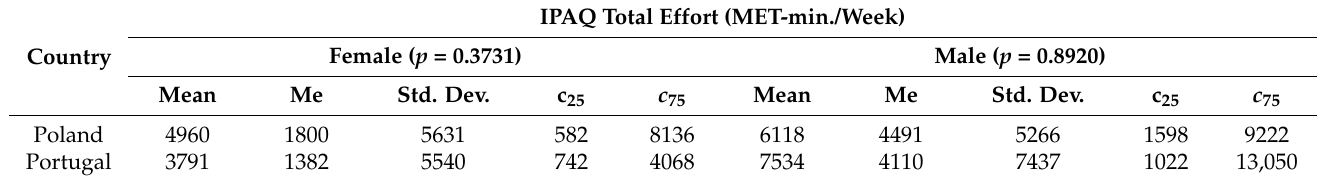
Table 4. Measure of total physical activity.